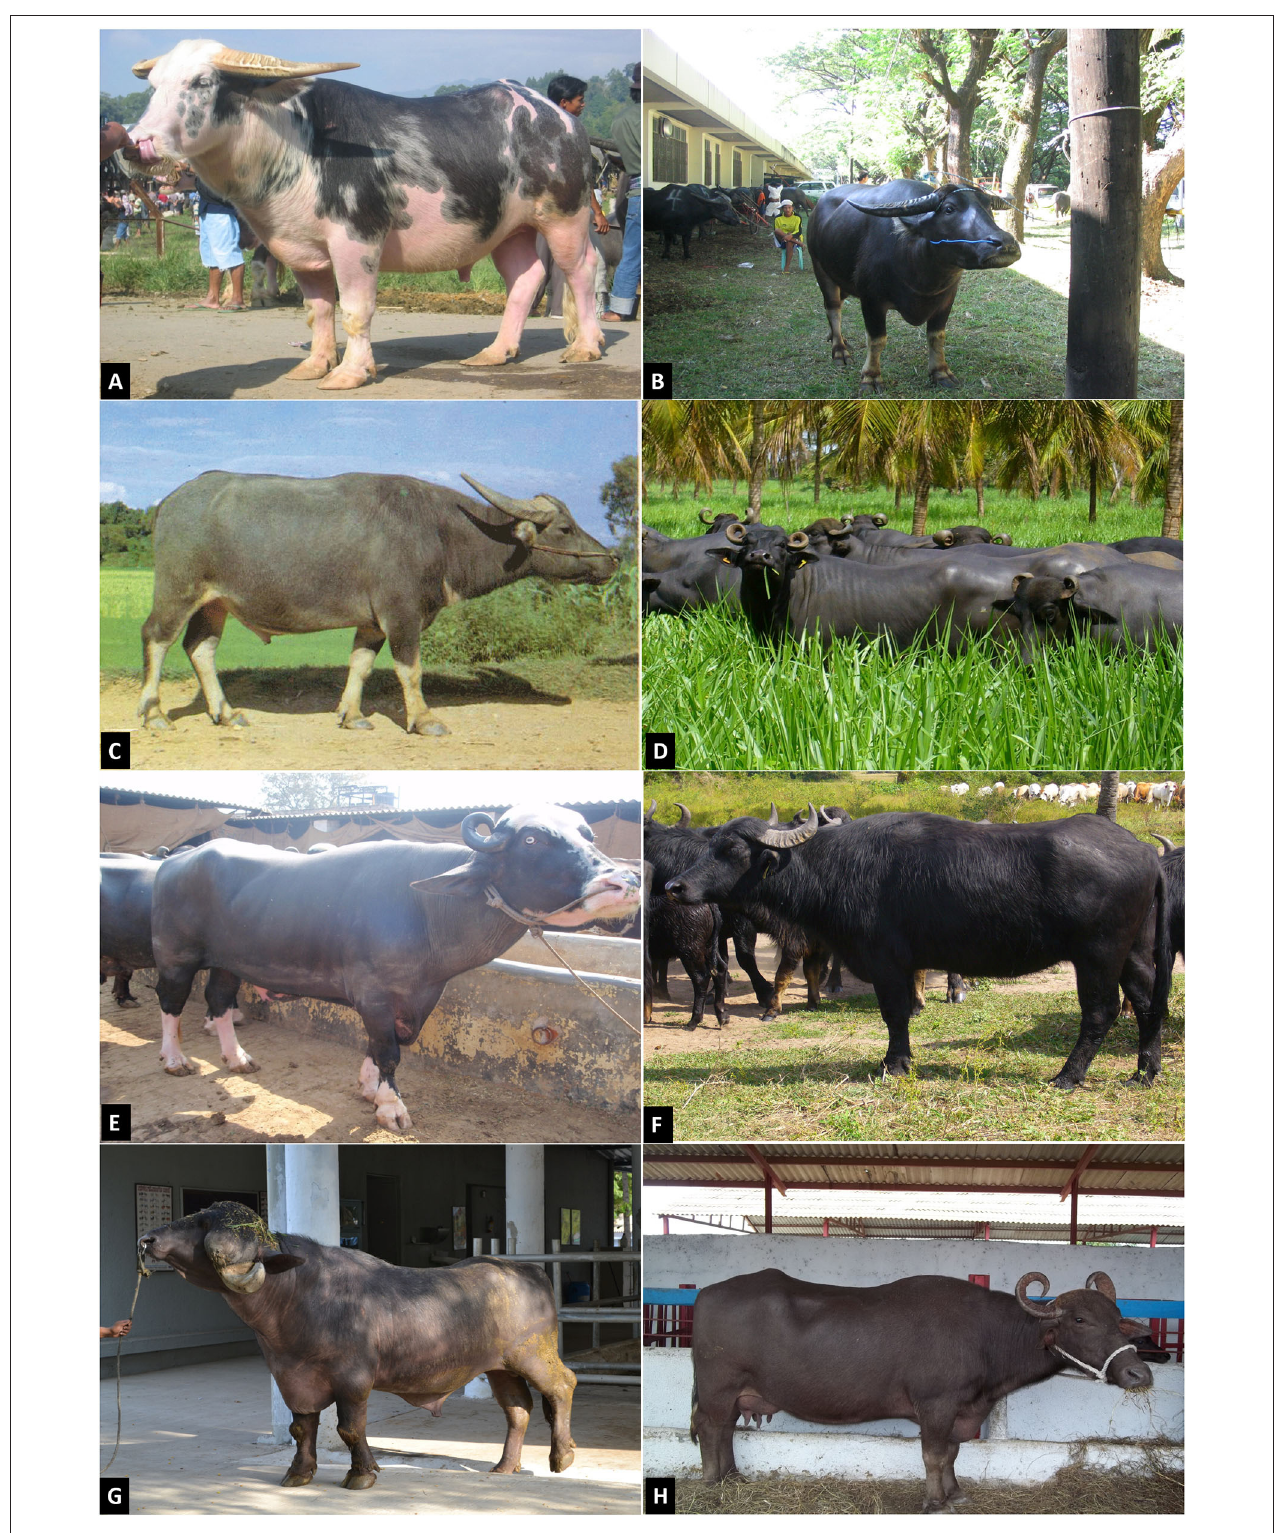
FIGURE 3 | Buffalo breeds worldwide. (A) Sulawesi breed spotted animal (Indonesia); (B) the Carabao breed from Philippines; (C) Fuling breed in China; (D) Murrah buffaloes herd from São Paulo, Brazil; (E) Nili-Ravi breed at Pakistan; (F) Mediterranean Italy breed raised in Mozambique; (G) Jaffarabadi bull in Brazil; (H) Buffalypso breed from Trinidad and Tobago. Source: Castro, S.R., Borghese (7).